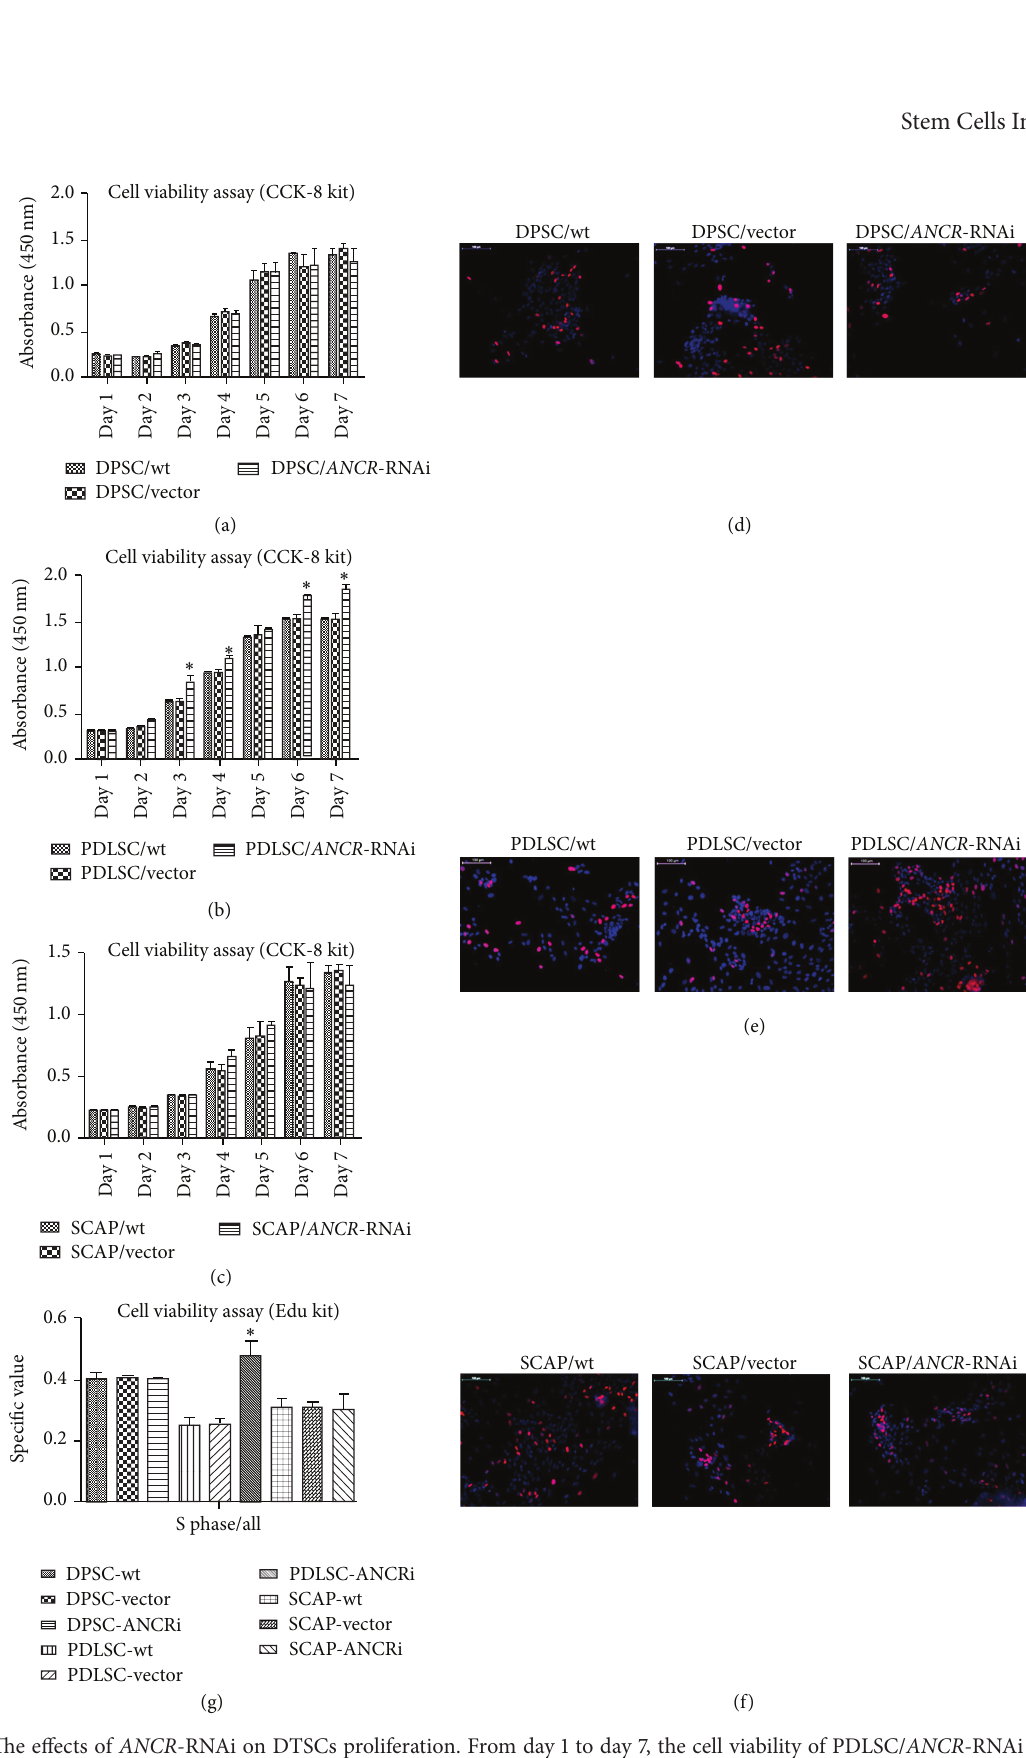
Figure 2: The effects of ANCR -RNAi on DTSCs proliferation. From day 1 to day 7, the cell viability of PDLSC/ ANCR -RNAi cells (b) was greater than that of the control cells; however, there were no statistically significant differences in DPSCs (a) and SCAP (c). Edu assay showed that there were more PDLSC/ ANCR -RNAi cells (e) in S phase (purple) than control cells. However, there was little difference between ANCR - RNAi cells and control cells in DPSCs (d) and SACP (f). The cell counting result confirmed this result (g). The specific value of cells in S phase was higher in PDLSC/ ANCR -RNAi cells compared to the control group; however, there were no statistically significant differences in DPSCs and SCAP. ∗ 𝑃 < 0.05 when compared with the control group. Bars 100 𝜇